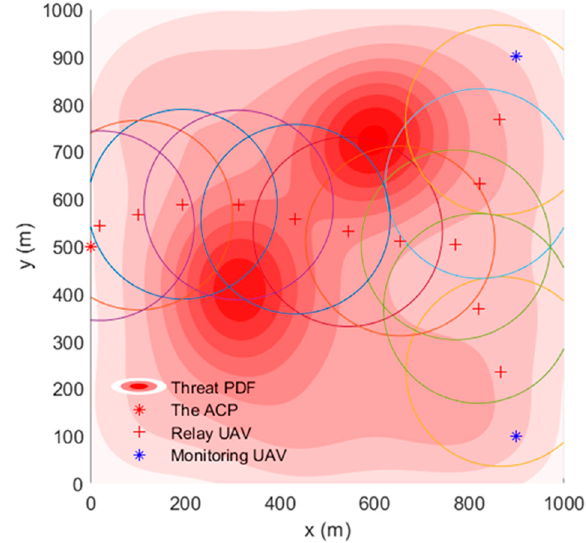
Figure 4. UAVs’ topology using TA&CRFO algorithm at